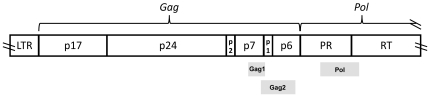
Regions analyzed in the HRM assay.The figure shows the regions of the HIV genome analyzed in the HRM assay (Gag1, Gag2, Pol). The HIV genome is represented by a non-shaded bar. The HRM amplicons are represented by shaded bars. LTR: long terminal repeat; PR: protease; RT: reverse transcriptase.